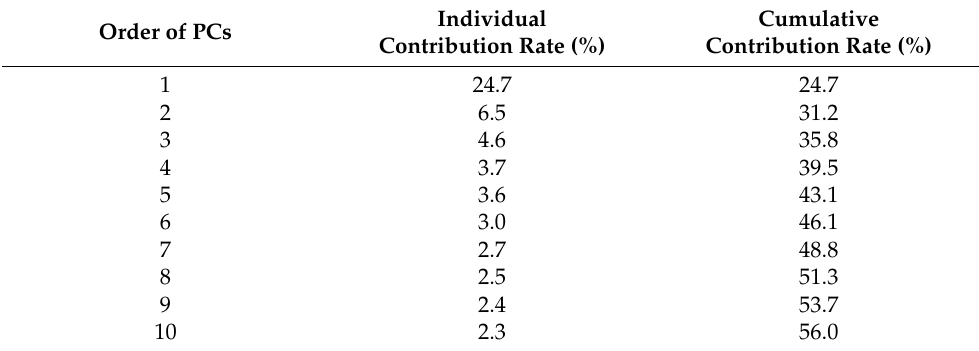
Table 1. Individual contribution rate and cumulative contribution rate of the top ten PCs.